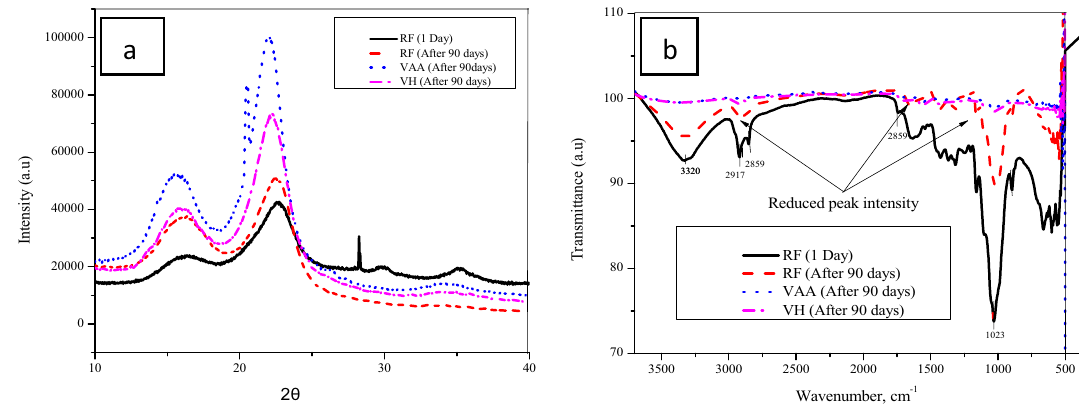
Figure 7. Characterization techniques ( a ) X-ray diffraction and ( b ) FTIR-ATR analysis of hand sheet exposed at VOCs